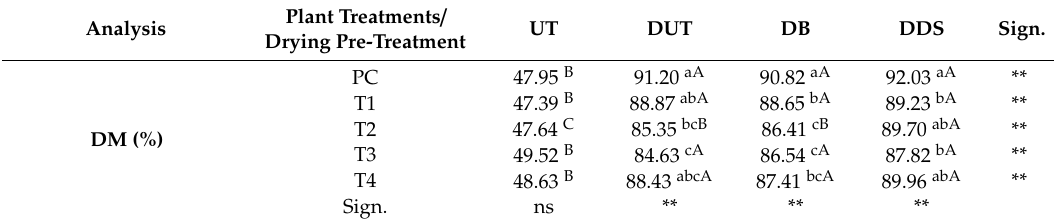
Table 6. Physicochemical and antioxidant characterization of drying treated olives (Exp. 2). Plant Treatments / Analysis UT Drying Pre-Treatment